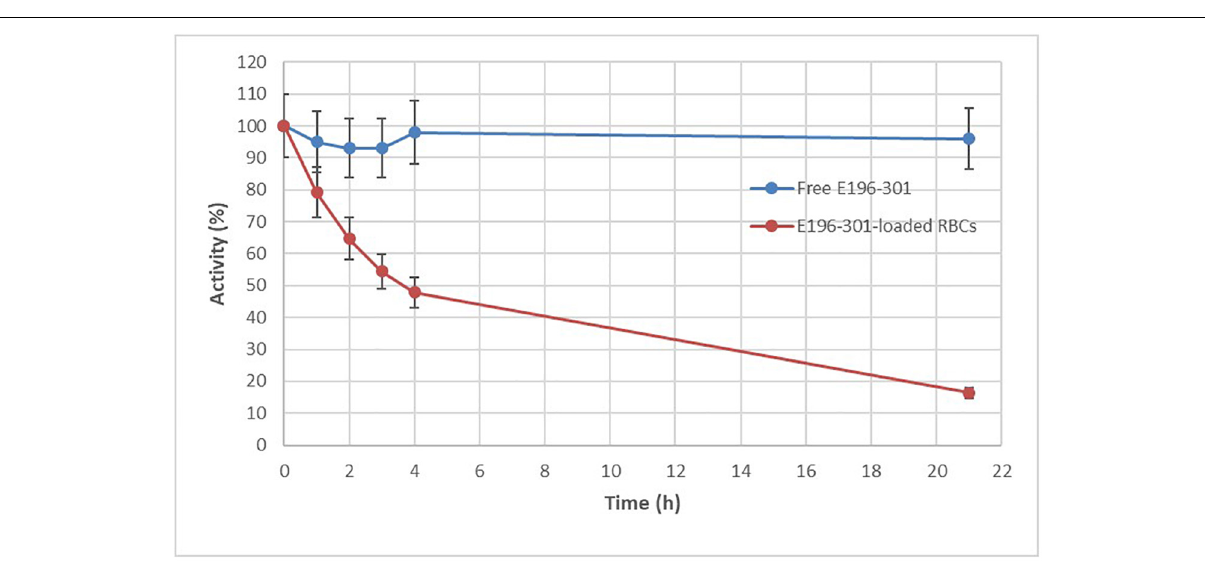
FIGURE 4 | E196-301 stability in free and in red blood cell (RBC) encapsulated form. In vitro stability of free and RBC-loaded E196-301 at 37 ◦ C in PBS, pH 7.2. Free enzyme was tested at 15 ± 1 IU/ml, while RBC-loaded enzyme was tested at 16 ± 1 IU/ml RBCs. All experiments were in duplicate that agree within 7.5%. Results are mean ± SD of three different